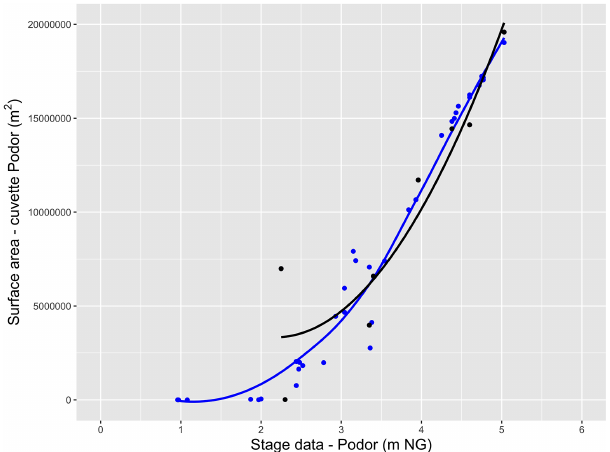
Figure 4. Relationship between stage data at Podor and remotely sensed flooded areas in the Podor floodplain during flood peak, (i) with 8 SPOT images (black line), (ii) with Landsat and Sentinel- 2A imagery (blue line).